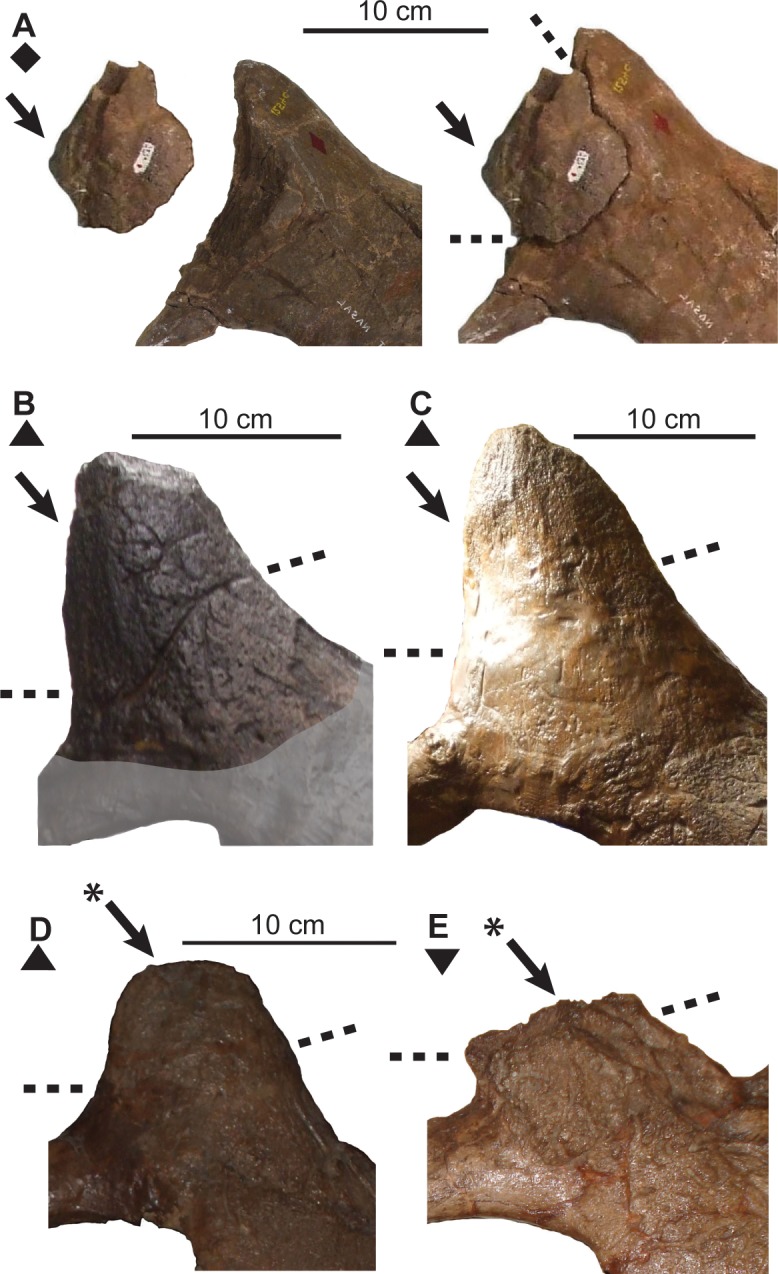
Ontogenetic changes in nasal horncore of Chasmosaurus.Articulation of epinasal with nasals (character 2) and subsequent resorption of nasal horncore (character 3): (A) epinasal disarticulated (CMN 1254; flipped), (B) epinasal articulated with suture open (CMN 2245), (C) epinasal articulated with suture closed, and (D) (YPM 2016) and (E) (CMN 8800) horncore partly resorbed. Arrows = confirmed or inferred epinasals; arrows with asterisks = resorbed surfaces; dashed lines = confirmed or inferred sutural contacts; plaster reconstruction = grey. Chasmosaurus belli (triangles), Chasmosaurus russelli (inverted triangle), and Chasmosaurus sp. specimens (diamond). [planned for column width].